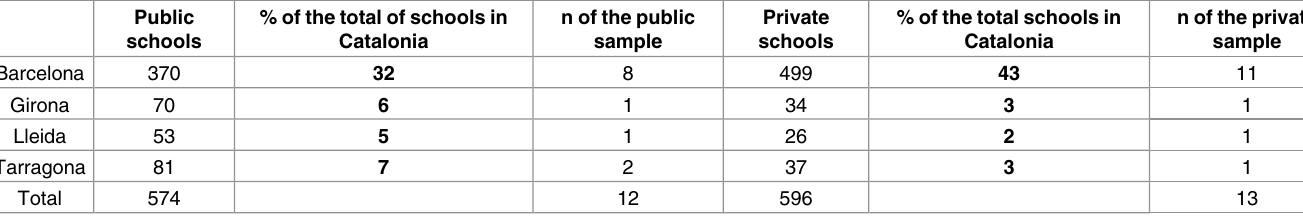
Table 1. Stratified sampling of the schools based on ownership and